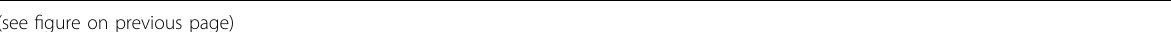
(see fi gure on previous page) Fig. 7 EpCAM + Gli1 + organoids differentiate into functional hepatocytes and ef fi ciently repopulate FRG liver after transplantation. a Schematic illustration of the experimental design. b RT-qPCR analysis of Krt19 , EpCAM , Alb , and HNF4 α in expansion medium (EM) or differentiation medium (DM). Data are represented as means ± SEM ( n = 3). c Immuno fl uorescence analysis of the hepatocyte marker genes Alb (green) or HNF4 α (red) in DM. Scale bar, 50 μ m. d Glycogen accumulation was determined by periodic acid-Schiff (PAS) staining in organoids grown in EM or DM for 12 days. Scale bar, 50 μ m. e LDL uptake was analyzed using an LDL fl uorescent substrate (red) in organoids that were maintained in EM or DM for 12 days. Scale bar, 50 μ m. f Albumin secretion in EM or DM for 12 days. Data are shown as means ± SEM ( n = 3). g Measurement of the cytochrome activity of CYP3A4 in EM or DM for 12 days. Relative light units (RLUs) per mL per million cells are shown. Data are presented as means ± SEM ( n = 3). h Immuno fl uorescence staining for FAH (green) and tdTomato (red) showing the engraftment of FAH + hepatocytes in FRG recipient livers at 3 months post transplantation. Scale bar, 10 μ m. i , j Serum levels of ALT and AST were determined at 3 months post transplantation. Data are shown as means ± SEM ( n = 3). k Immuno fl uorescence staining for tdTomato (red) and HNF4 α (green), KRT19 (green), or EpCAM (green) at 3 months after transplantation. Scale bar, 50 μ